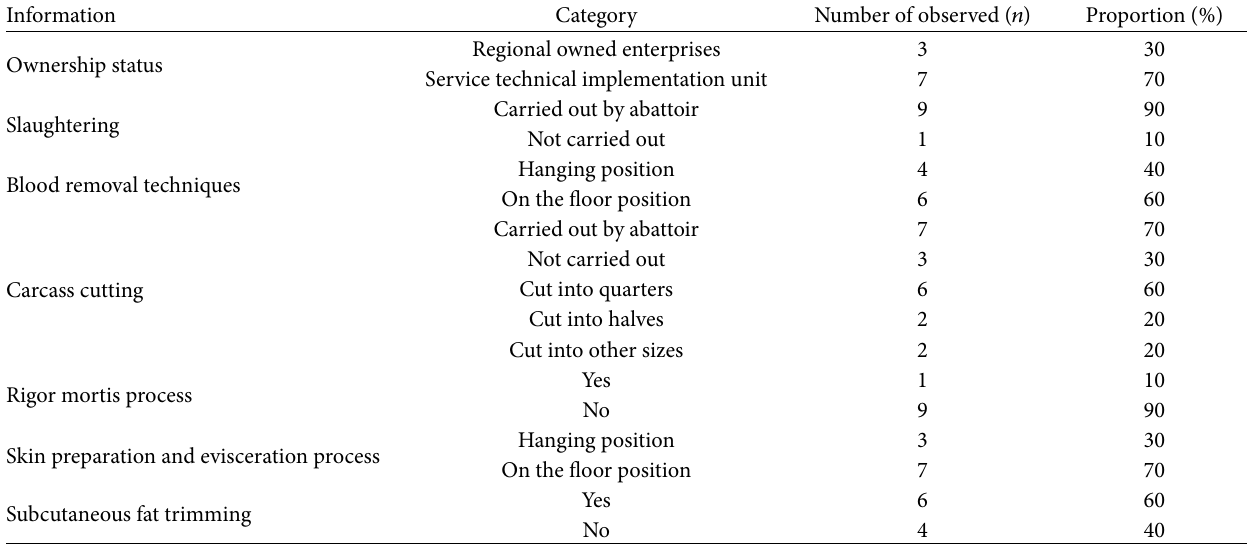
Table 1: General information of ten selected